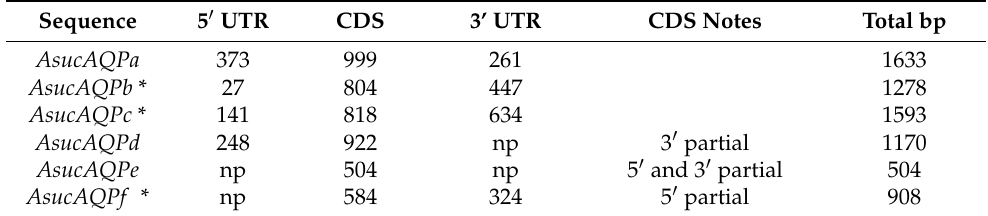
Figure 1. Evolutionary distribution of the annelid Aqps identified in this study, based on amino acid data. Annelid phylogenetic tree derived from the work in [31] and was combined with the Clitellata tree adapted from in [59]. Annelids belonging to Errantia are in blue (below) while families belonging to Sedentaria are in orange (above). Aqp classification according to phylogenetic relationship recovered in Figure 2. Letters following the species indicate the source of the analyzed data: G = genome; T = transcriptome; P = protein. Table 1. The six Aqp transcripts annotated in the transcriptome of A. succinea published by Kocot and coworkers [43]. Asterisk: Aqps amplified by RT-PCR and sequenced; CDS: coding sequence, corresponding to the ORF; np: not